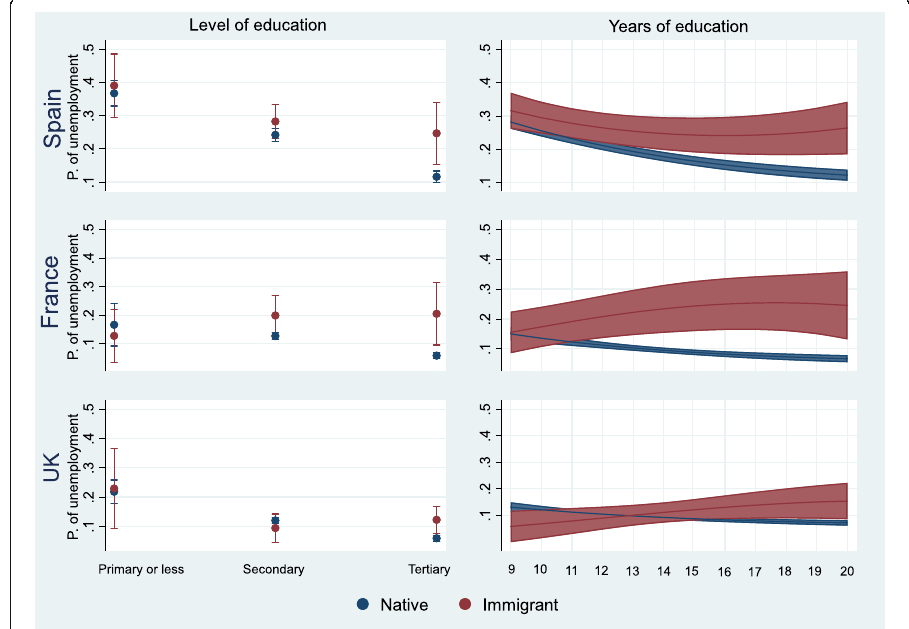
Fig. 1 Risk of unemployment for immigrants and natives by educational level and years of education, separately by country of residence. Source : Estimated from models in (Table 3 in